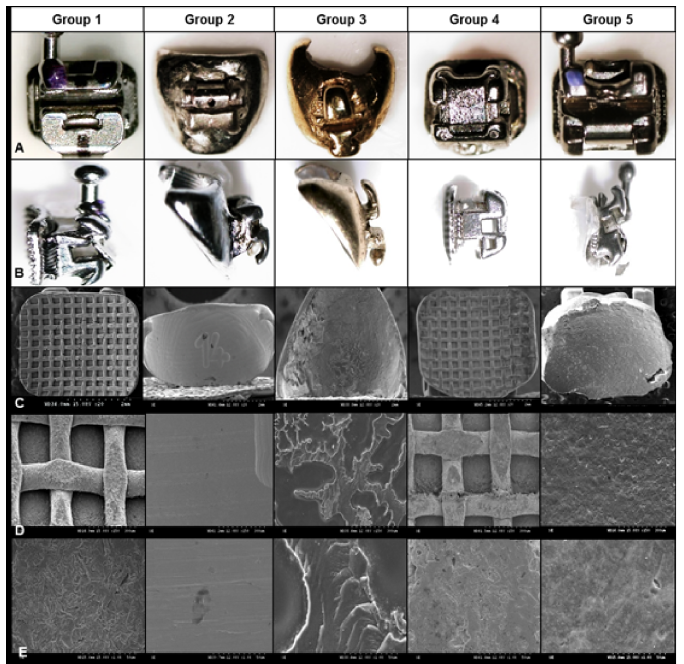
Fig 3. Stereo microscope and SEM imagines of bracket specimens. Stereo microscopic frontal and lateral imagines of bracket specimens and scanning electron microscopy imagines of bracket bases. A. Frontal view; B. Lateral view; C. Bracket bases (20 × ); D. Bracket bases (150 × ); E. Bracket bases (1000 × ).Group 1, preadjusted bracket; Group 2, Harmony; Group 3, Incognito; Group 4, Insignia; Group 5, Orapix. https://doi.org/10.1371/journal.pone.0202952.g003 were found between preadjusted and Harmony brackets, which were 62.77 N (SD 12.65) and 196.90 N (SD 82.75), respectively. Further, statistically significant differences in shear bond strength were found between Incognito and Orapix brackets, which were 3.58 N (SD 2.14) and